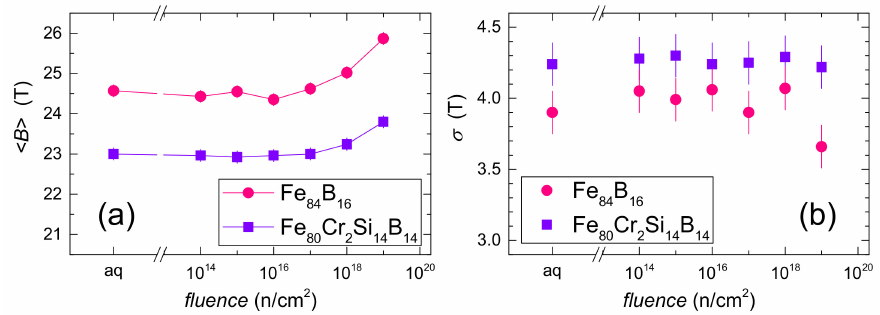
Figure 4. Parameters of distributions of hyperfine magnetic fields, P ( B ), obtained from Mössbauer spectra of Fe 80 Cr 2 Si 14 B 14 and Fe 84 B 16 , plotted against the neutron fluence: ( a ) Average hyperfine magnetic field, (cid:104) B (cid:105) ; ( b ) standard deviation, σ